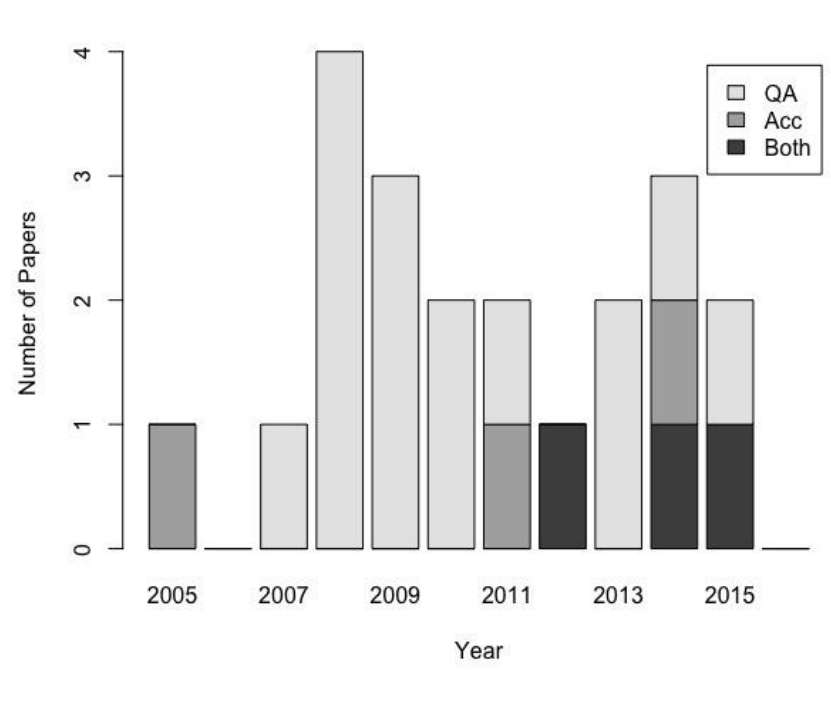
Figure 5. Frequency of published papers